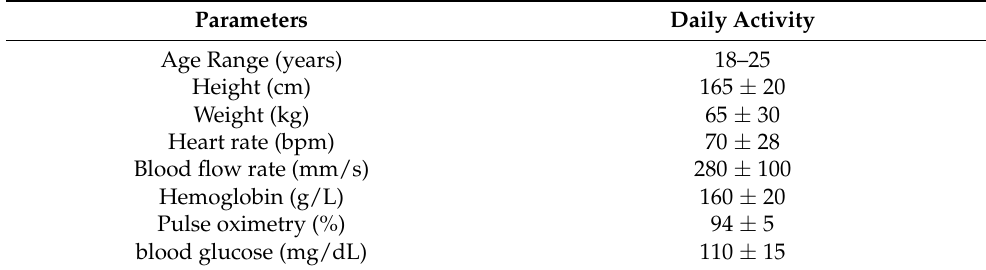
Table 1. Physiological characteristics of the